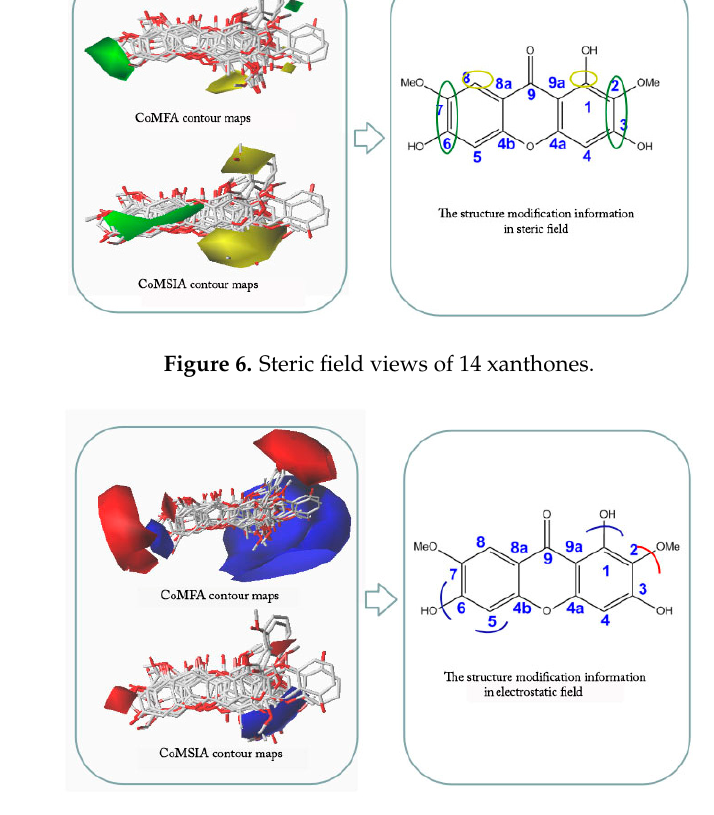
Figure 7. Electrostatic field views of 14 xanthones.